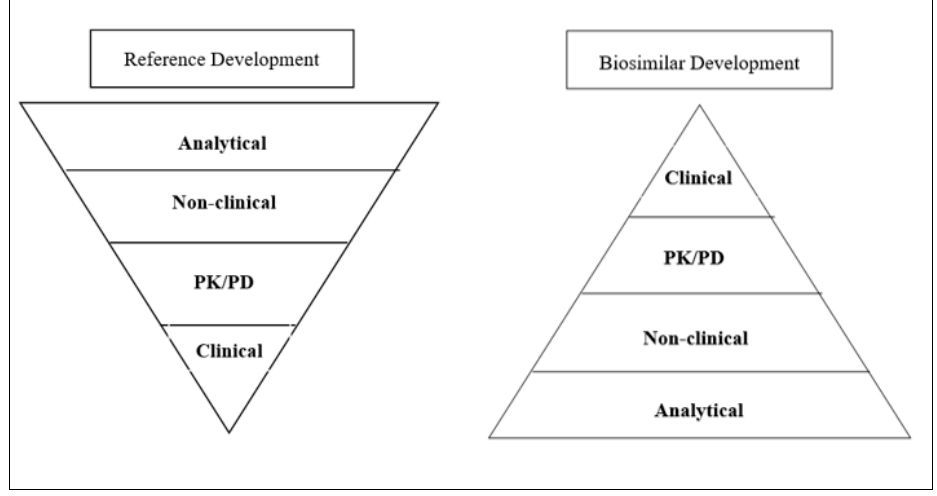
Figure 4. Comparison of the pre-marketing development processes of reference biologic and biosimilar.